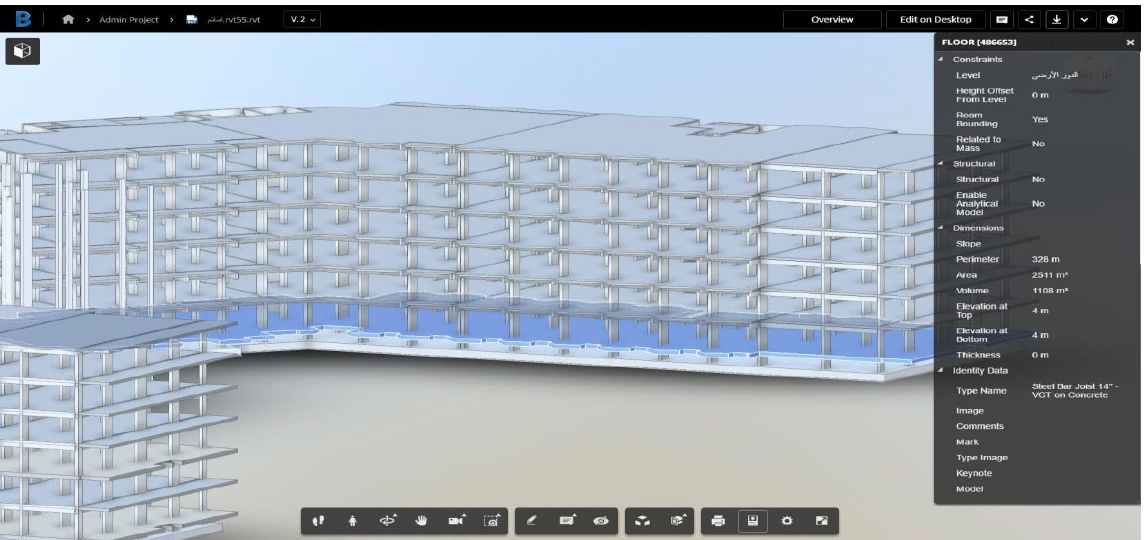
Figure 4: BIM 360 Doc (3D Struc. Model View – The military Hotel/ALAMEIN).